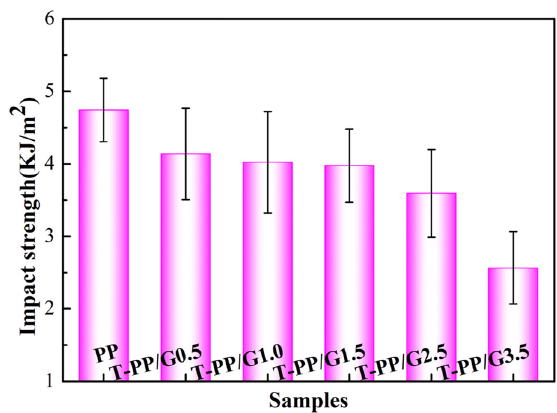
Figure A3: Impact strength of neat PP and composites prepared by two - screw